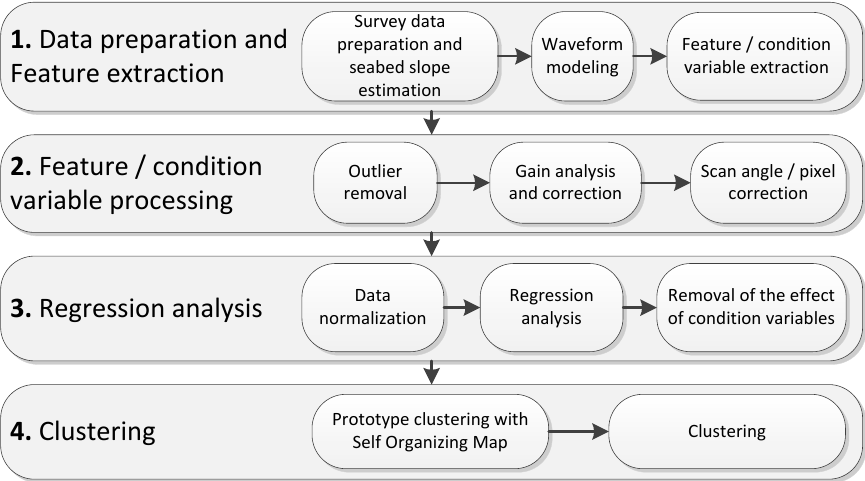
Figure 5. Process flow of the algorithm for LiDAR waveform